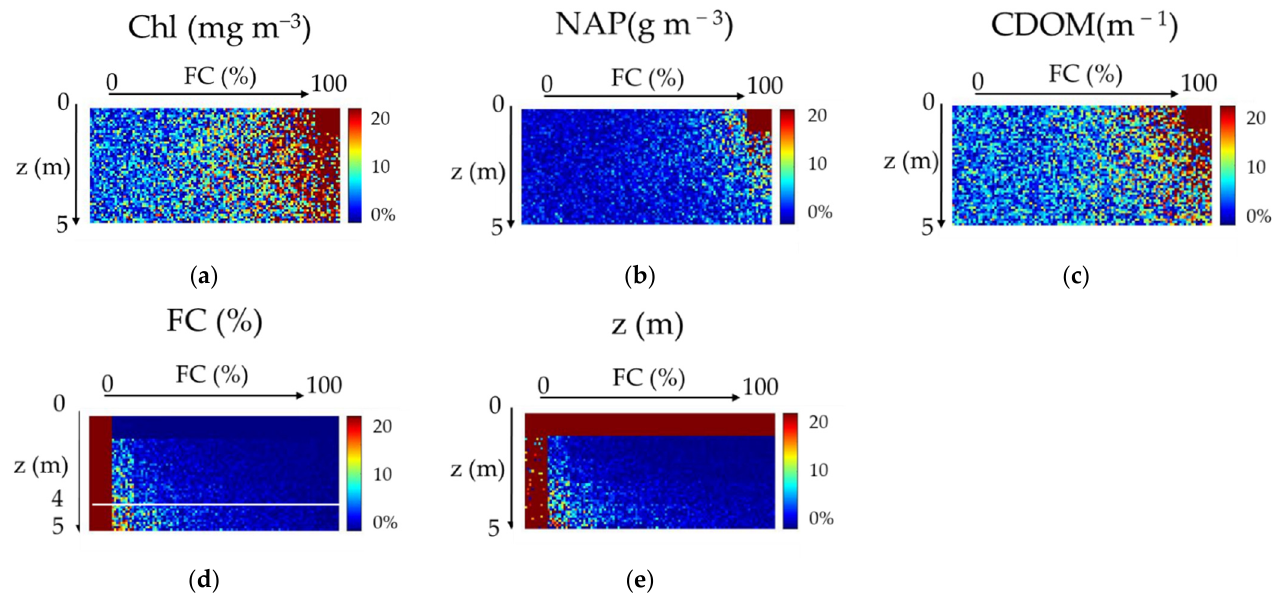
Figure 5. Relative error (RRMSE) of each bio-optical parameters retrieved using the SRT inversion method: FC varies on the horizontal axis from 0 to 100% and depth z varies on the vertical axis from 0 to 5 m. ( a ) Chlorophyll (Chl), ( b ) Non-Algal Particle (NAP), ( c ) Colored Dissolved Organic Matter (CDOM), ( d ) Fractional Coverage (FC), ( e ) Depth (z).